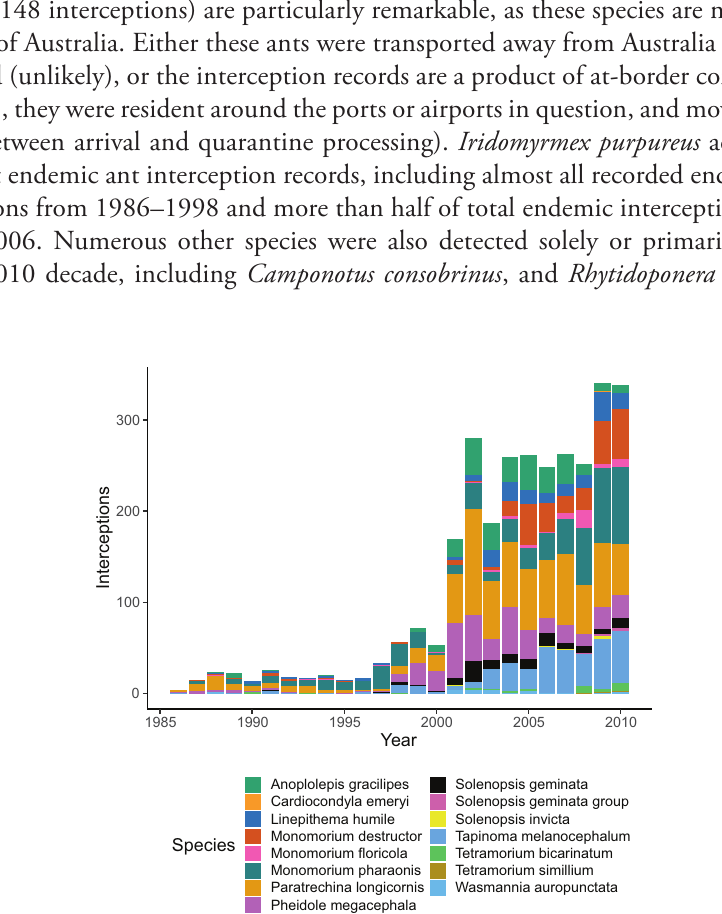
Figure 6. The most common identified introduced species intercepted in Australia ports of entry from